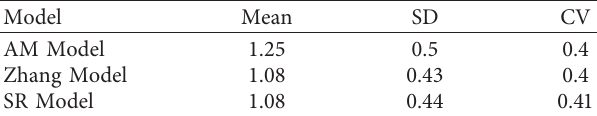
Table 9: The statistics of calculated ε under adhesive failure mode.